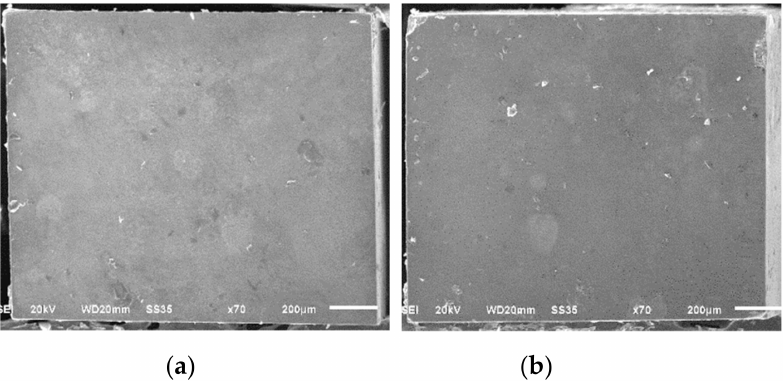
Figure 4. Representative SEM images of the surface of the debonded specimen: adhesive failure of a specimen from the fine-grit group. ( a ) Debonded specimens on resin composite fracture site of adhesive failure. ( b ) Debonded specimens on dentin fracture site of adhesive failure.